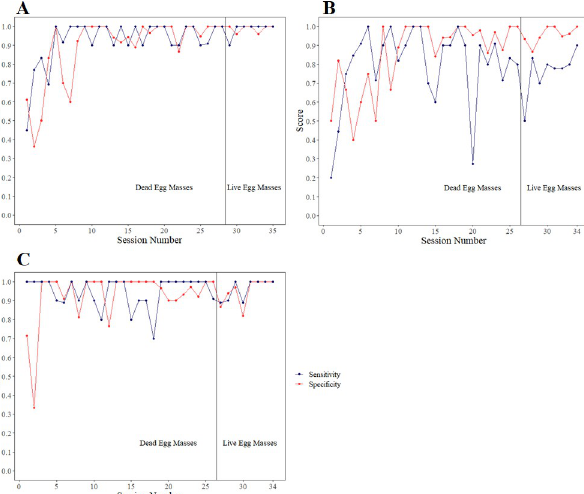
Fig 8. Graphs for the sensitivity and specificity for Grizzly (A, top left), Pacy (B, top right), and Toby (C, bottom).